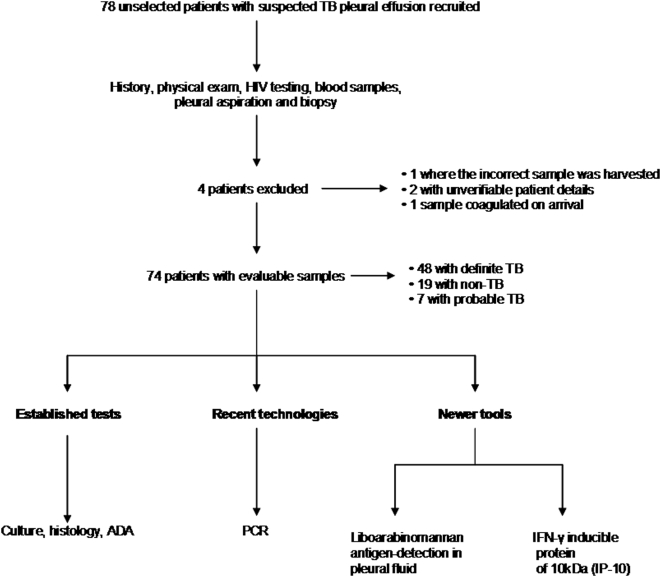
Summary and flow chart of the established and newer technologies evaluated.